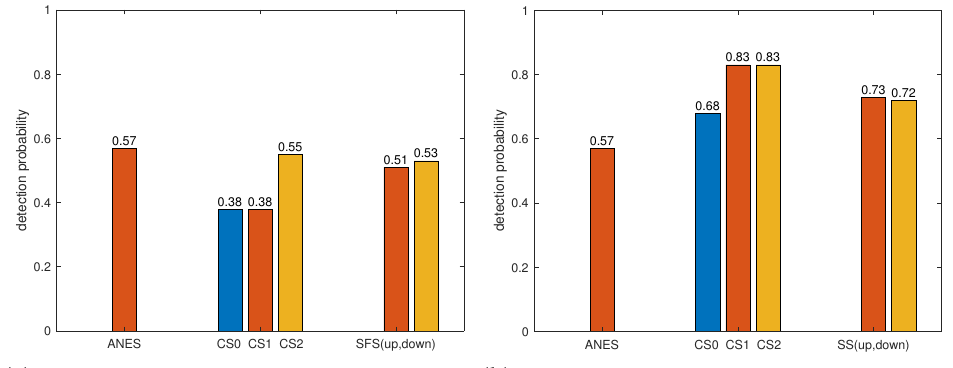
( b ) The radar with ANES and the jammer with elemen- tary strategies